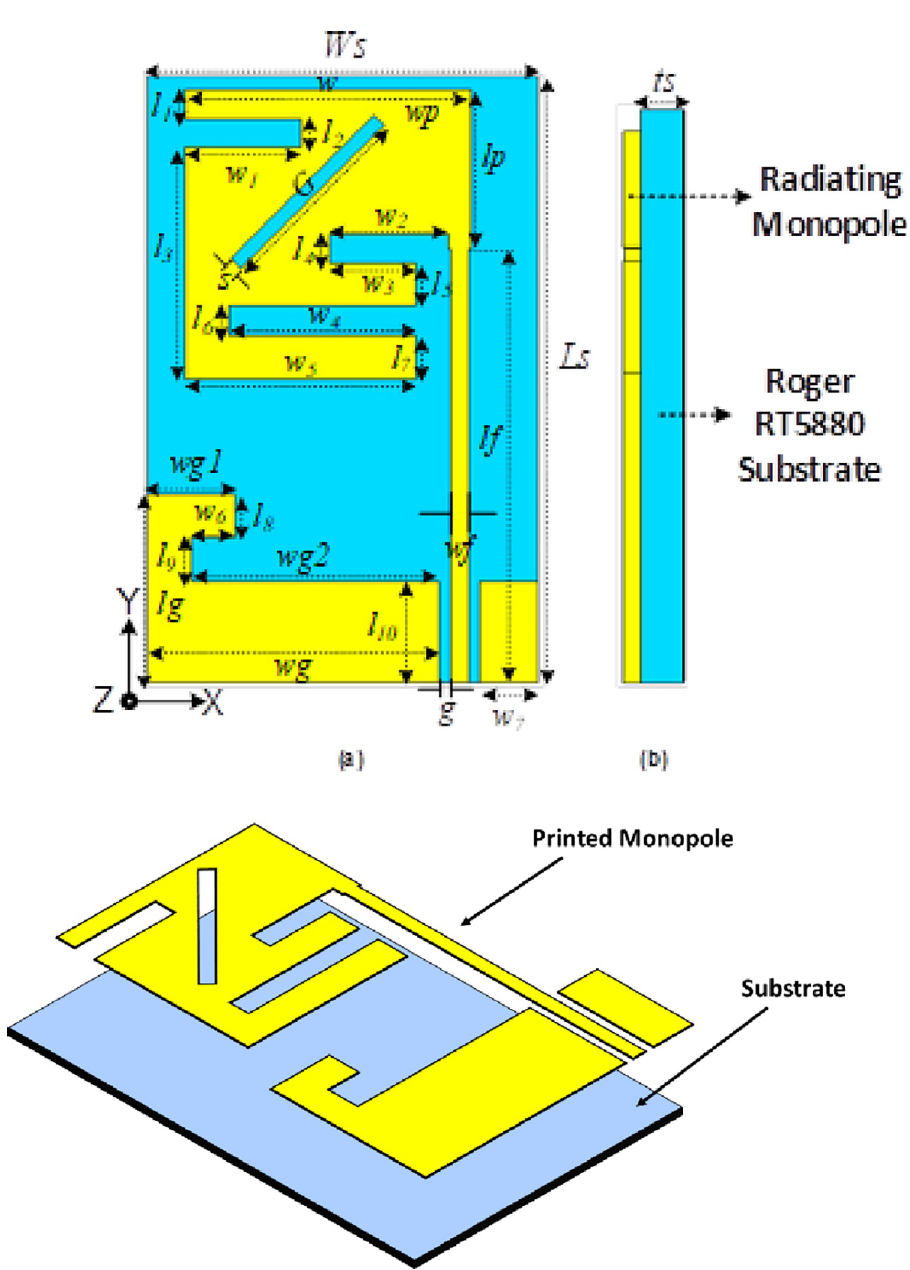
Fig 2. Antenna proposal with dimensions, (a) front view, (b) side view, and (c) 3D perspective.